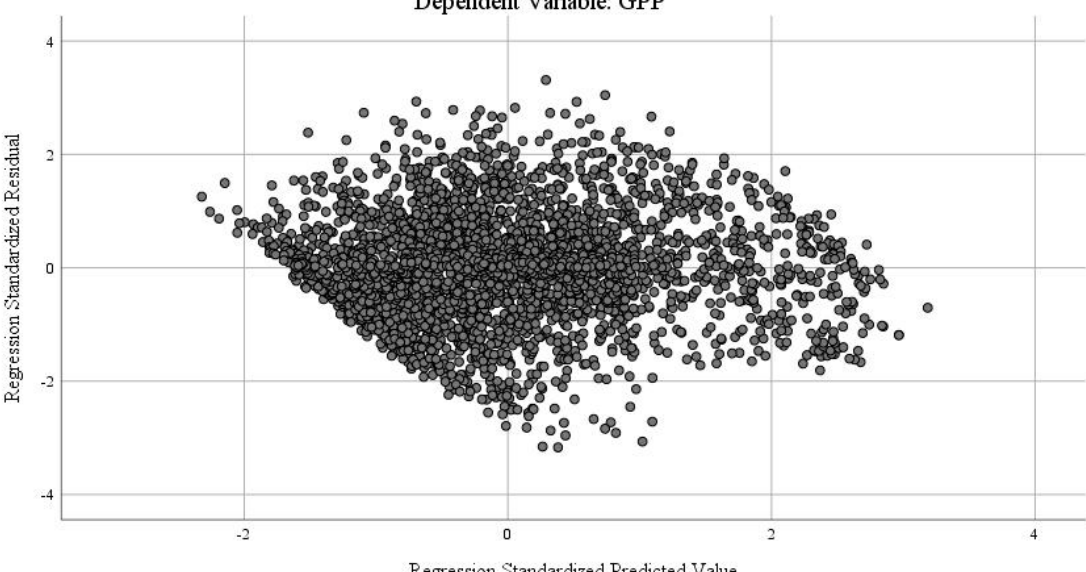
Figure A8. Scatterplot of the standardised residuals and the standardised predicted values using the natural logarithm of N deposition for the class grasslands and the year 2000. Table A 1 Pearson’s correlation between GPP: Gross primary productivity and Ln N dep: Natural logarithm of N deposition, Temp: Temperature, Precip: Precipitation, and Sunsh: Sunshine, based on a bootstrap of 1000 samples per land cover class and year. **Statistically significant p < 0.01 .